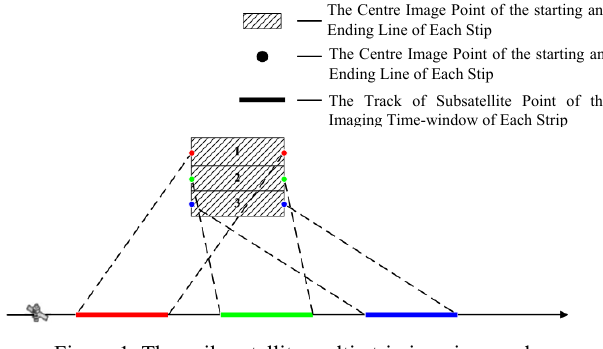
Figure 1. The agile satellite multi-strip